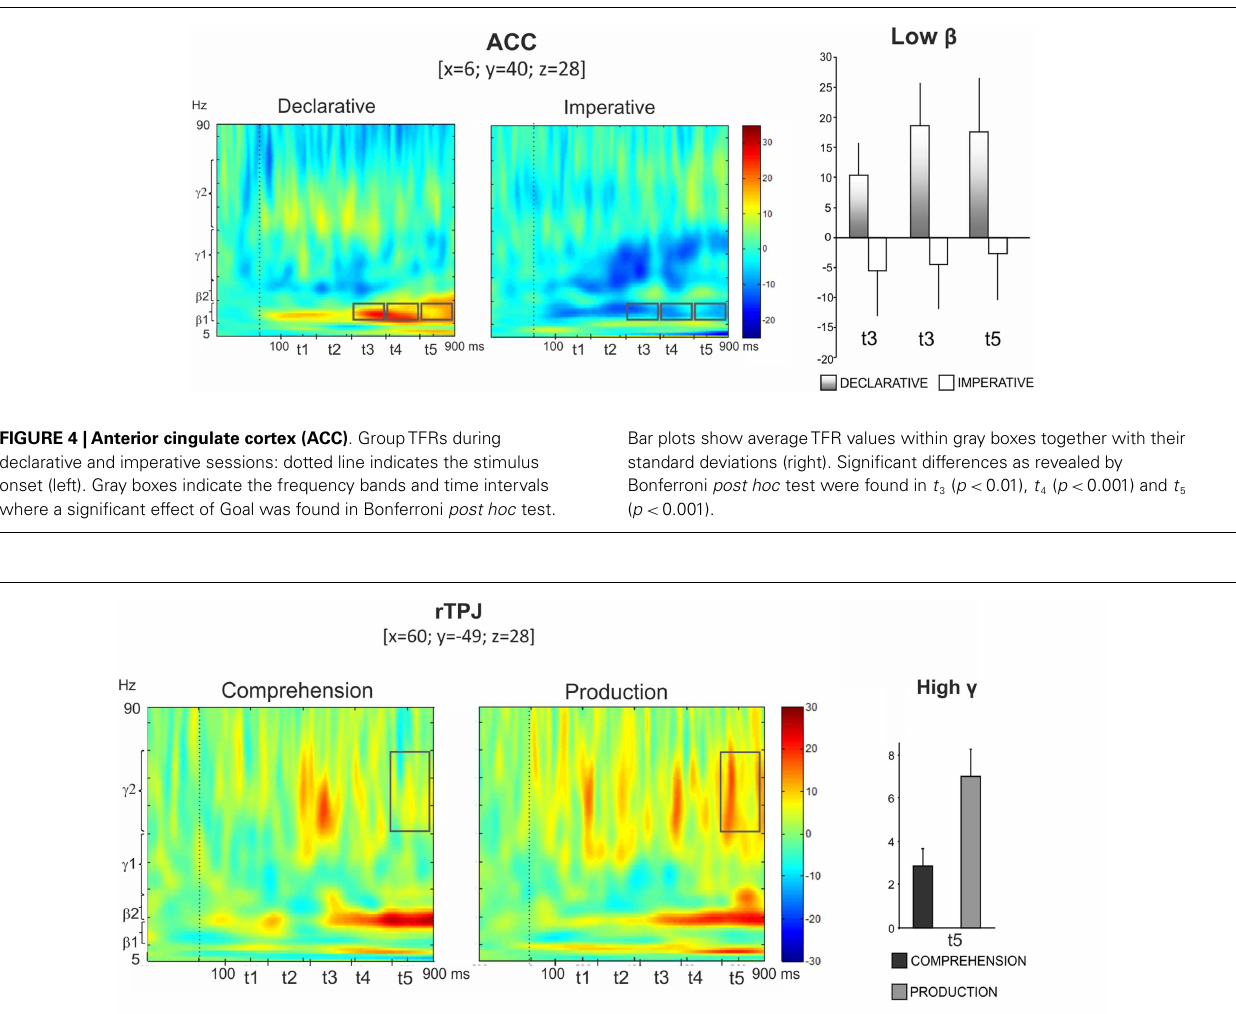
Bottom : right posterior superior temporal sulcus (rpSTS). GroupTFRs during declarative and imperative sessions (right). Significant increased high beta power during the declarative condition as well as a decreased high beta power during the imperative condition were observed in the frequency and time intervals marked by superimposed gray boxes. Bonferroni post hoc evidenced a significant difference during t 3 ( p < 0.05) and t 4 ( p < 0.01)